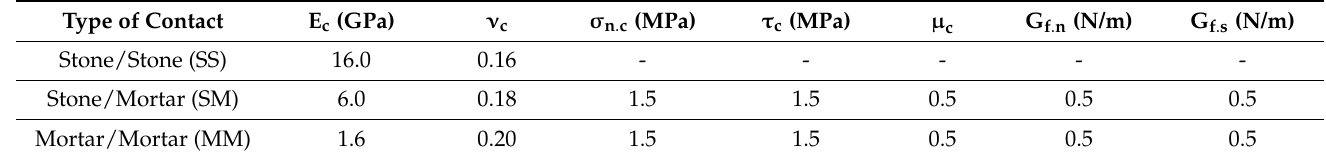
Table 4. Contact elastic and strength properties for the rubble masonry